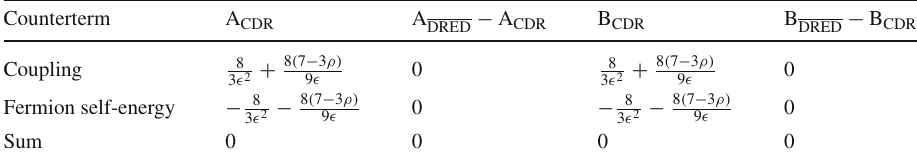
Table 9 Counterterm results for spinorial QED using CDR and DRED,